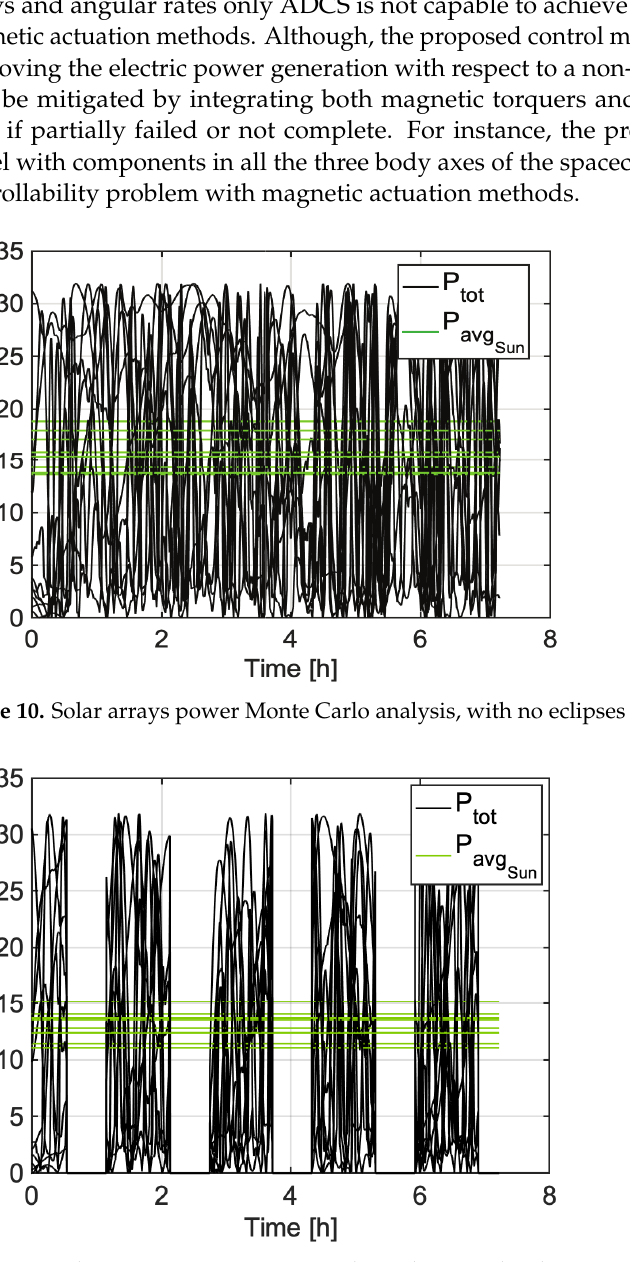
Figure 11. Solar arrays power Monte Carlo analysis, with eclipses and magnetic